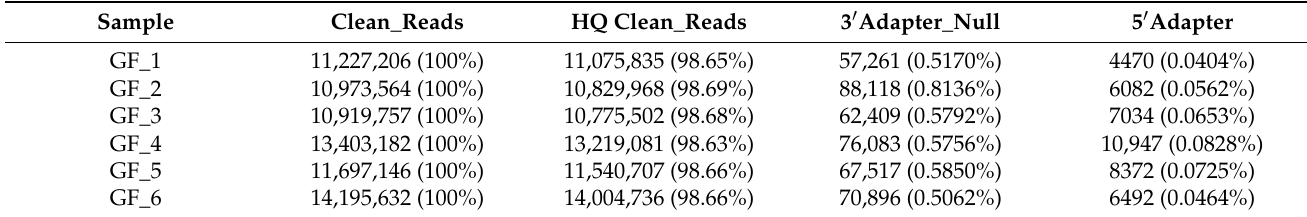
Table 2. Summary statistics of miRNA sequencing